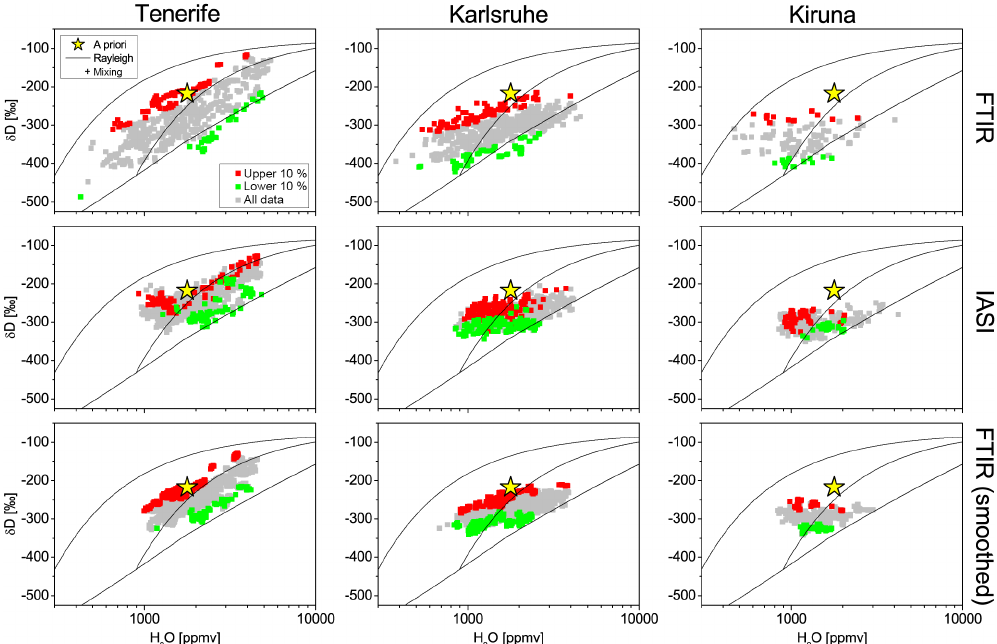
Figure 6. {H 2 O, δ D} pair plots for 4.9km altitude for coincident FTIR and IASI measurements for the three locations: Tenerife, Karlsruhe, and Kiruna. The FTIR data, the IASI data and FTIR data smoothed with the IASI averaging kernels are plotted (from the top to the bottom). The colour code displays the upper 10% and lower 10% of δ D values as identified in the FTIR data. The black lines and the yellow stars are the same as in Fig. 5 (Rayleigh line, mixing lines and a priori value for 5km altitude, respectively). For more details on this kind of validation approach, please refer to Wiegele et al.